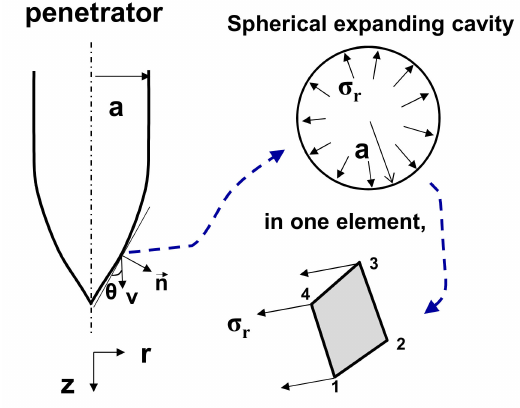
Figure 3. Schematic figure of the finite cavity pressure